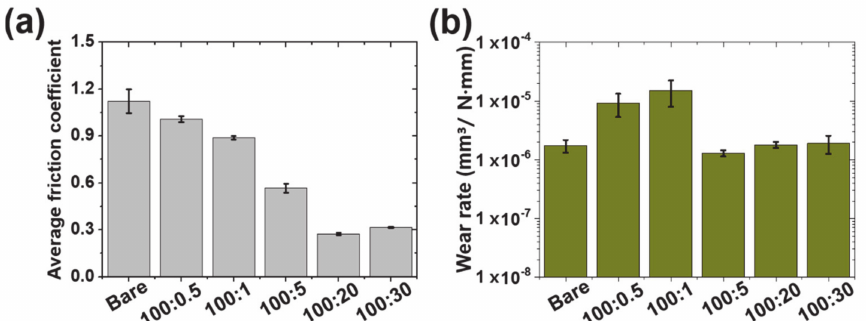
Figure 5. ( a ) Average friction coefficient and ( b ) wear rate of each specimen with respect to PDMS/GB mixing ratio (PDMS 100: GB